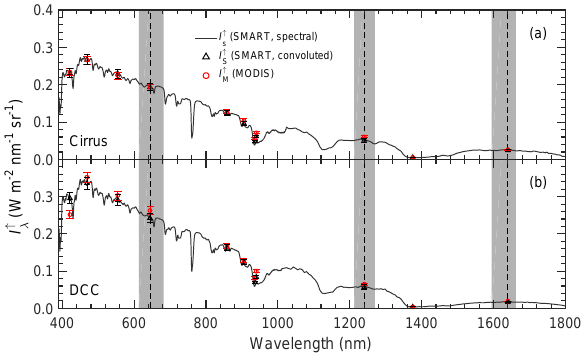
↑ Figure 7. Comparison of mean I measured by SMART and λ MODIS for the cirrus case (a) and the DCC case (b) at λ between 400 and 1800nm. Error bars represent measurement uncertainties. Wavelengths centered at λ = 645, 1240, and 1640nm are indicated by dashed lines, while grey bands correspond to the interval of MODIS relative spectral response R(λ) for the respective wave-